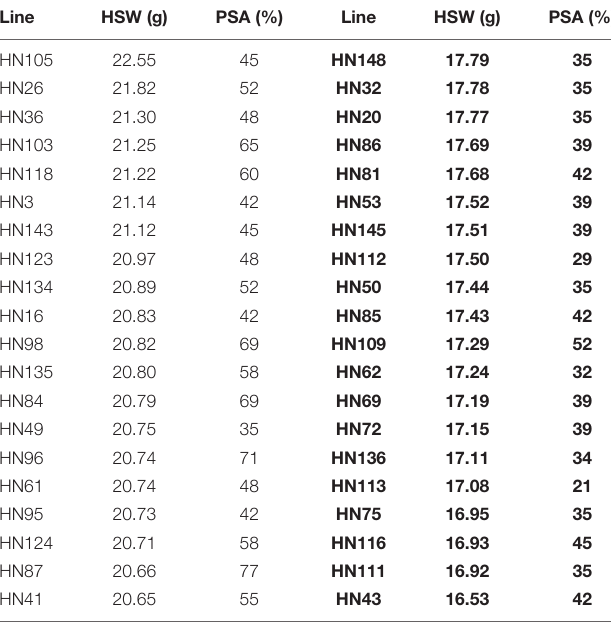
TABLE 4 | Phenotypic averages of hundred-seed weight and proportion of superior alleles in 40 lines across 31 common QTNs.